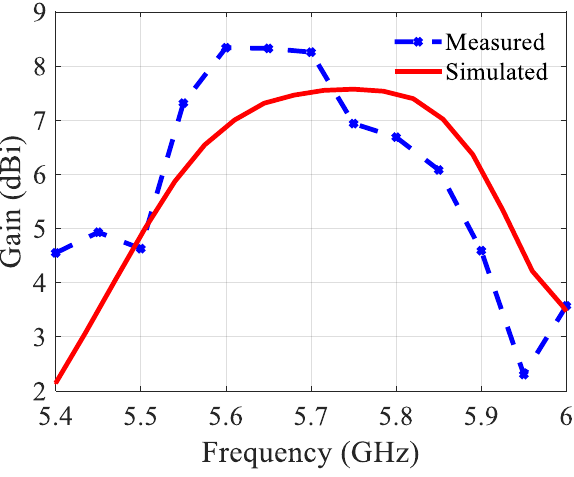
Figure 6. Gain of the 2 × 1 building block.